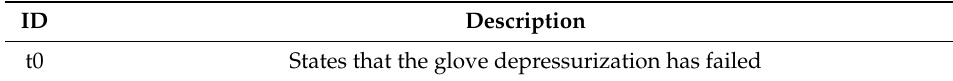
Figure 3. Depressurization failure page. Table 3. Description of the text field found on the glove depressurization page.